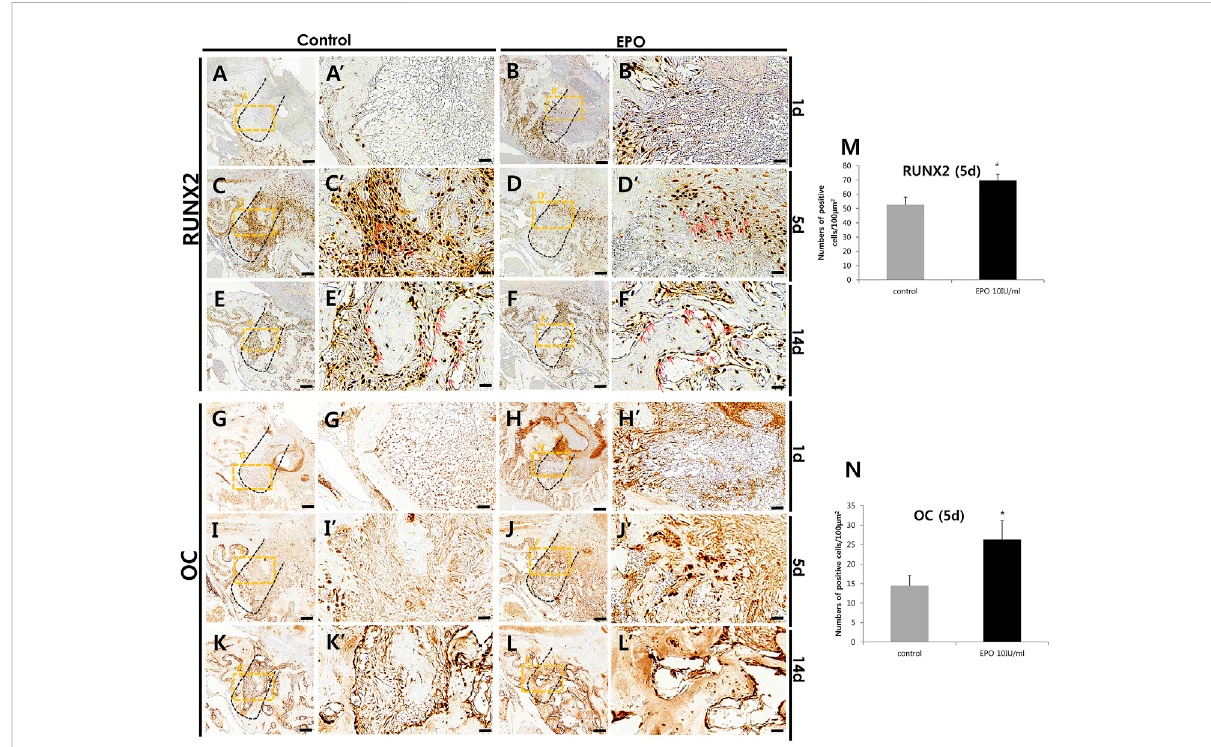
FIGURE 5 Representative photomicrographs of alveolar tissue sections stained with osteoblast markers in the control group (A,C,E,G,I,K) and EPO group (B,D,F,H,J,L) at 1, 5, and 14 days. Compared to control, the localization of Runt-Related Transcription Factor 2 (RUNX2) in the EPO group is more intense on day 1; however, its localization patterns are decreased on day 5 (A 9 ,B 9 ,C 9 ,D 9 ) . In 1-day specimens, the expression of RUNX2 is also more visible along the socket wall and in the apical 1/3 region of the experimental group (A 9 ,B 9 ) . In contrast, osteocalcin (OC) localization on the day 1 specimen is weaker in the EPO group; however, its localization pattern is increased on day 5 (G 9 ,H 9 ,I 9 ,J 9 ) . Speci fi cally, OC-positive cells are observed only along the socket wall in the control group, but in the entire socket in the EPO group (I 9 ,J 9 ) . However, on day 14, RUNX2 and OC are stronglyexpressedintheentiresocketofbothgroups (E 9 ,F 9 ,K 9 ,L 9 ) .RedarrowspointtopositivecellsagainstRUNX2 (C 9 ,D 9 ,E 9 ,F 9 ) .Histologicalanalysis using RUNX2 (M) and OC (N) at 5 days. Scale bar: X = 100 μ m, X ’ = 20 μ m (X ′ is higher magni fi cation of X). *Statistically signi fi cant differences compared to the untreated control ( p <